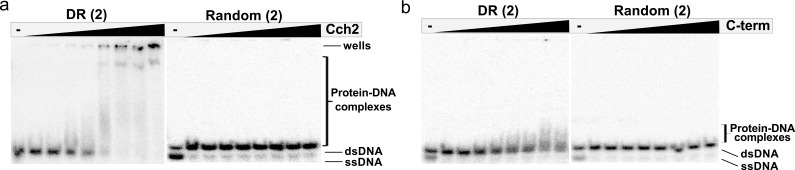
Binding of Cch2 and its C-terminal domain (C-term) to 23 bp ds-DNA oligos representing the DR from the putative origin of replication or a random sequence – repeat of the experiment shown in (a) Figure 3c and (b) Figure 3d.